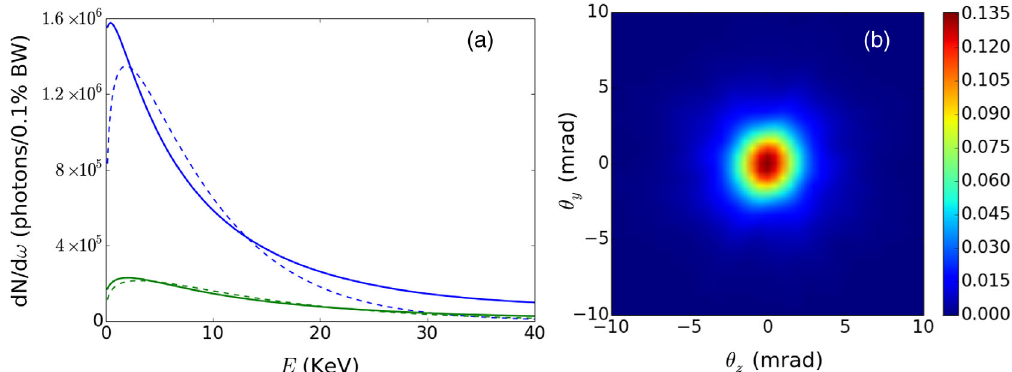
FIG. 9. Characteristics of x-ray emission in the blowout regime after 9 cm of propagation. (a) Solid curves: number of photons per 0 . 1% BW emitted through the entire simulation (blue) and only over the last centimeter of propagation (green). Dashed curves: synchrotron fits. (b) Angular energy distribution dI (J = d Ω